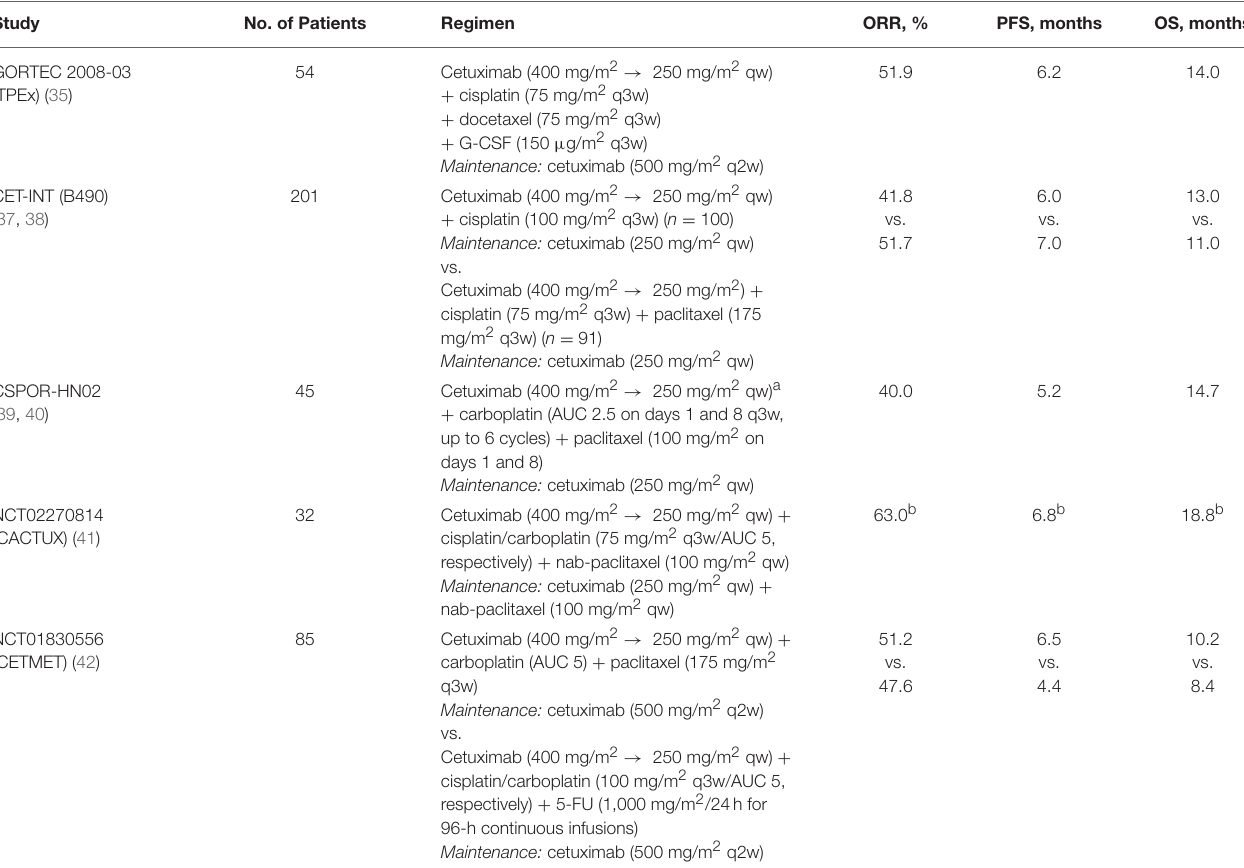
TABLE 1 | Efficacy of cetuximab + platinum + taxane regimens in first-line R/M SCCHN studies. Study No. of Patients Regimen ORR, % PFS,